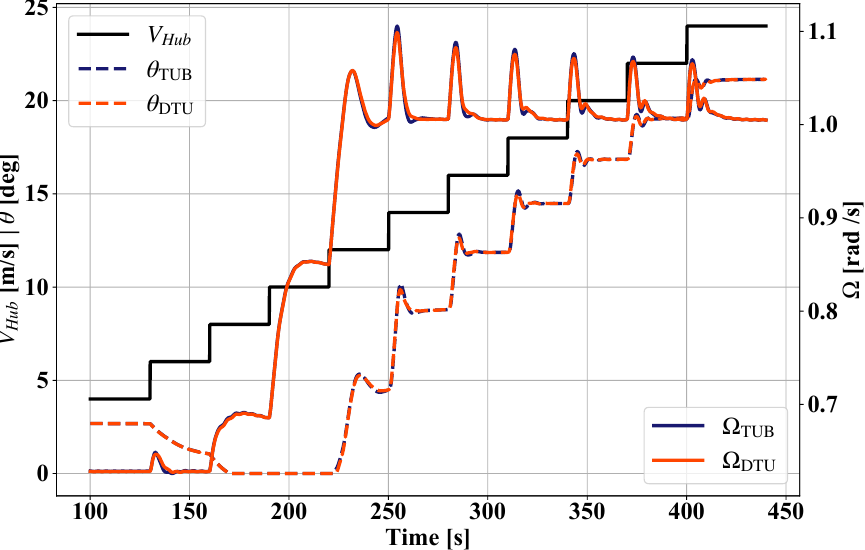
Figure 7. Validation of the controller in steady wind simulations. Pitch angle θ and rotor speed Ω of both controllers are compared for ascending wind